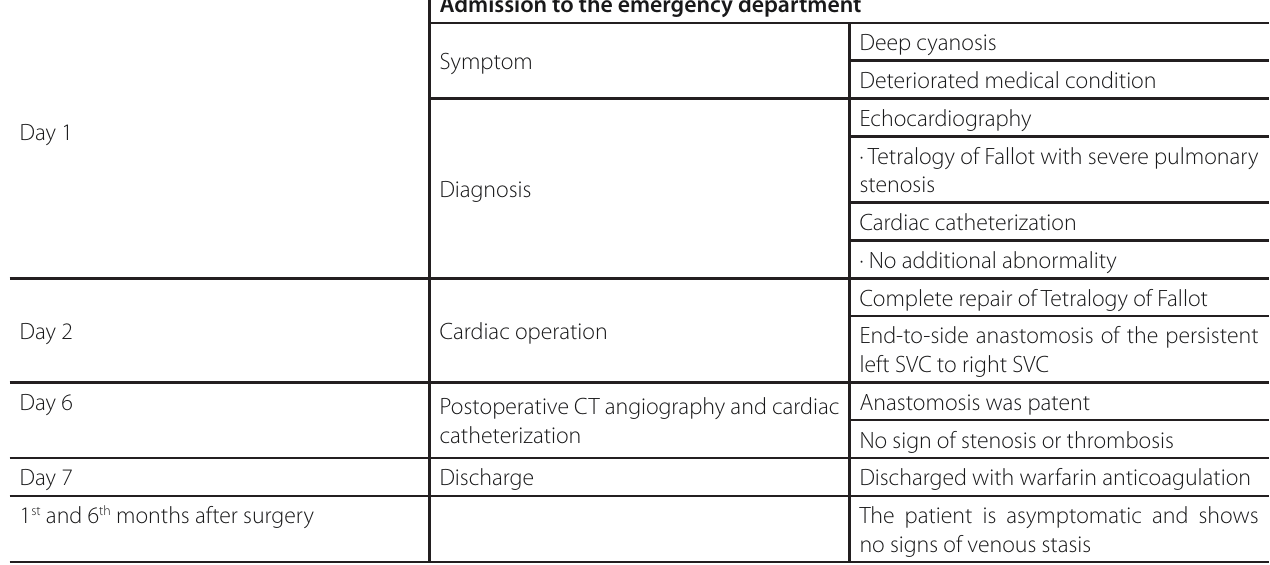
Table 1. Timeline of the case